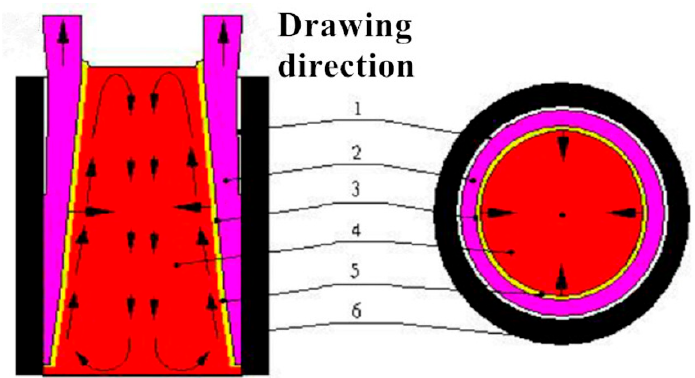
Figure 1. Convection of molten iron in the crystallizer ( left ) and the centripetal solidification in the crystallizer ( right ). 1—air gap, 2—solidified shell, 3—liquid/solid interface propelled from outside to inside, 4—molten iron, 5—high temperature molten iron layer formed by latent heat of crystallization, 6—graphite sleeve.